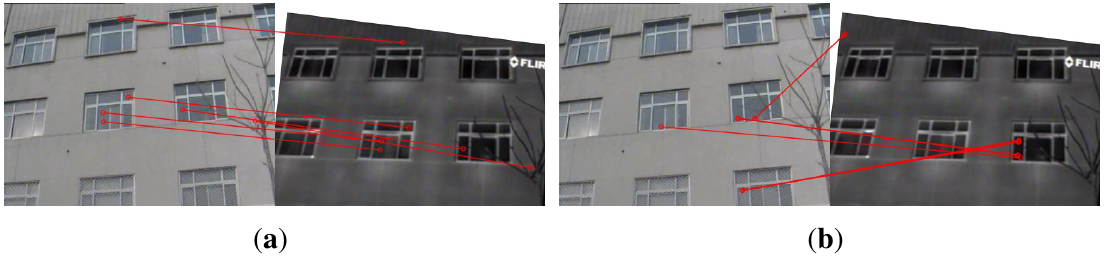
Figure 6. Matching result on an image pair from ‘EOIR’ taken by ourselves. The infrared image is transformed to investigate the matching performance under rotation. ( a ) The proposed method performs well under rotation; and ( b ) SIFT + RANSAC yields some incorrect matches due to the repeating windows of buildings. Such incorrect mappings are very difficult to remove, since the local gradient patterns (descriptors) of the windows lying in different position are similar to each other.